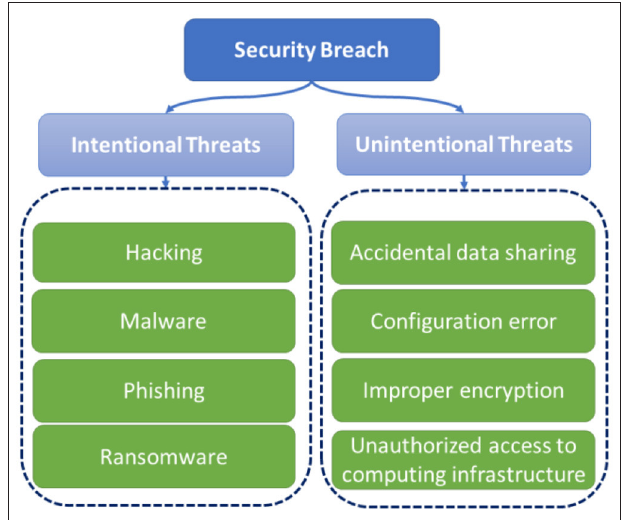
FIGURE 1 | Classification of security